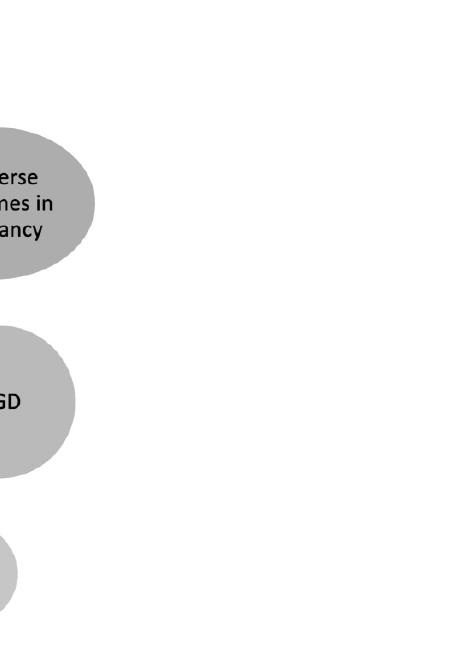
Figure 3. Obesity in Women. Abbreviations: SBP: Systolic blood pressure; GD: Gestational diabetes.